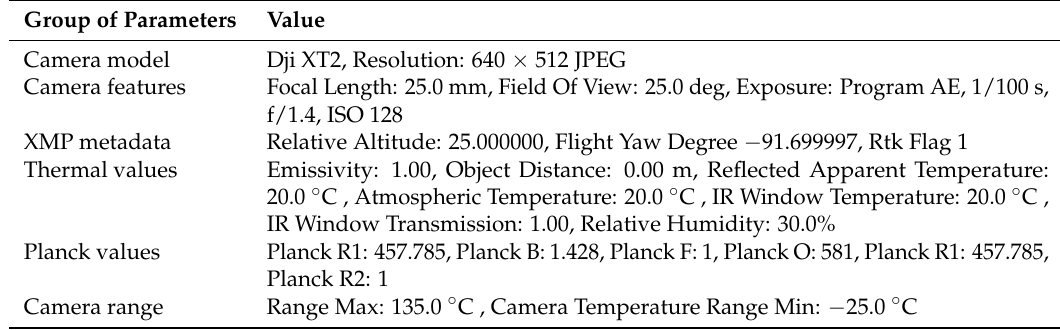
Figure 8. Acquisition process of the images over the photovoltaic plant. Table 1. Main parameters associated with each thermal image stored using